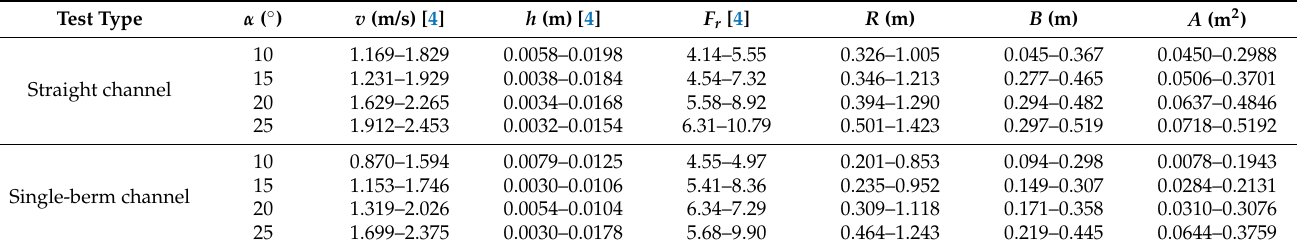
Table 3. Summary of observed data from laboratory